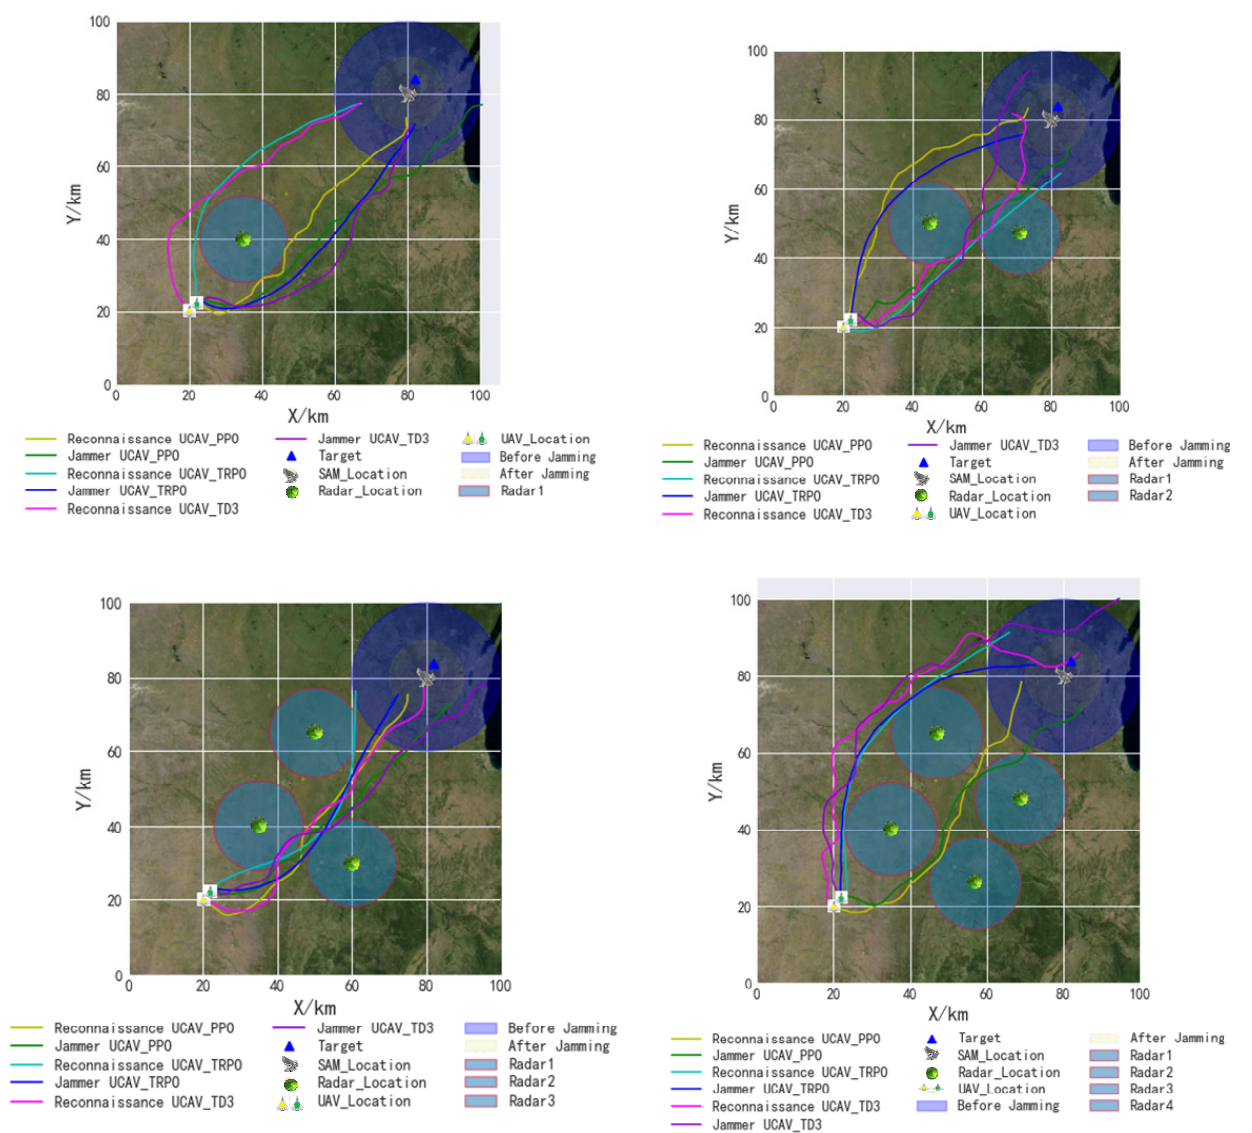
Figure 8. Intelligent mission planning under different situations.